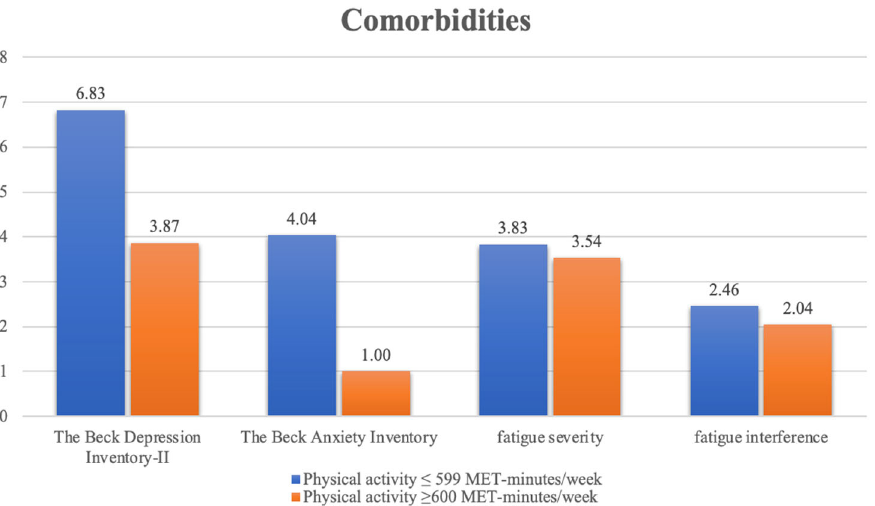
Figure 1. Comparison of physical activity and psychological distress of patients on hemodialysis.